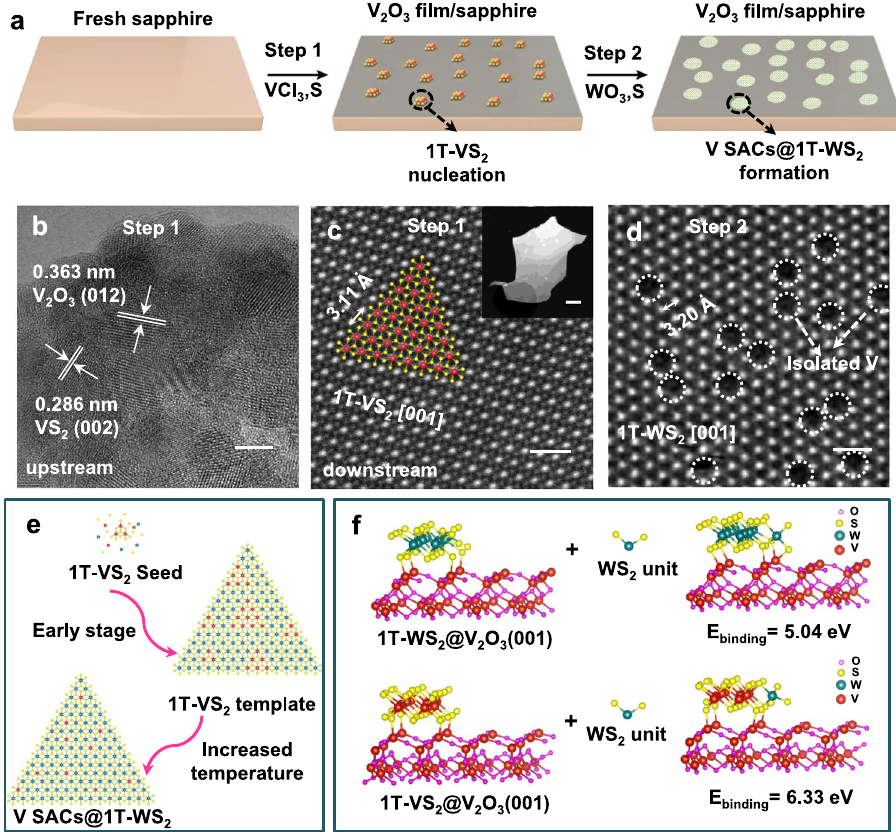
Fig. 4 Growth mechanism of V SACs@1T-WS 2 . a Stepwise-products experiments for the V SACs@1T-WS 2 growth process. b HRTEM image of V 2 O 3 - nuclei fi lm formed in the upstream of the sapphire substrate. c High-resolution HAADF-STEM image of 1T-VS 2 formed in the downstream of V 2 O 3 -nuclei fi lm/sapphire substrate. The red spheres and yellow spheres represent the V atoms and S atoms, respectively, in the schematic model of 1T-VS basal plane. Inset: low-resolution of HAADF-STEM image of VS 2 domain. d High-resolution HAADF-STEM image of V SACs@1T-WS 2 formed on the surface of V 2 O 3 -nuclei fi lm. The V atoms are highlighted by the dashed white circles. e The proposed growth mechanism of V SACs@1T-WS 2 formed on the V 2 O 3 fi lm. f Computed binding energy of WS 2 unit on 1T-WS 2 vs 1T-VS 2 on the surface of V 2 O 3 (001). Scale bars: ( b ) 5 nm; ( c ) 0.5 nm, inset 50 nm; ( d ) 0.5